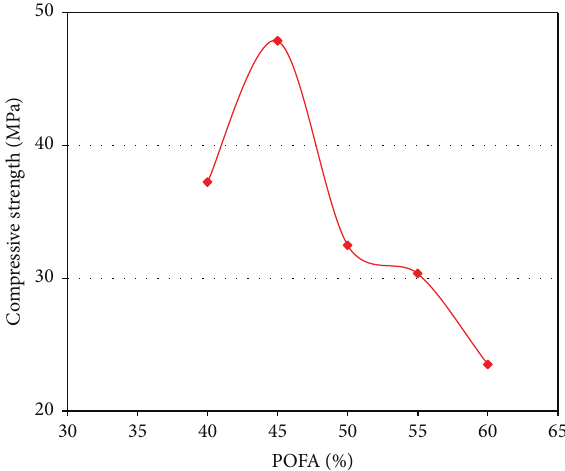
Figure 16: Effect of POFA on compressive strength mixed with MK and 35% fixed